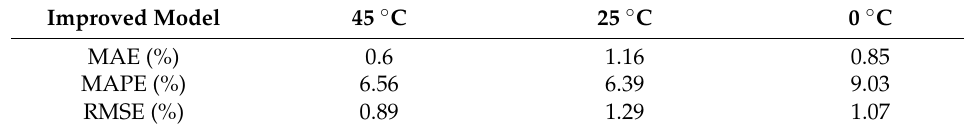
Table 3. Comparison of the model estimation results after improving the recurrent block.